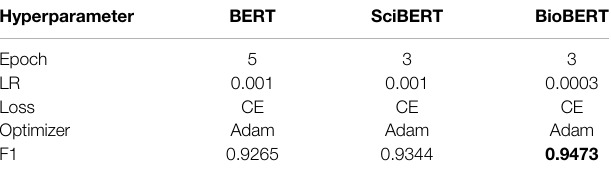
TABLE 7 | SciBERT